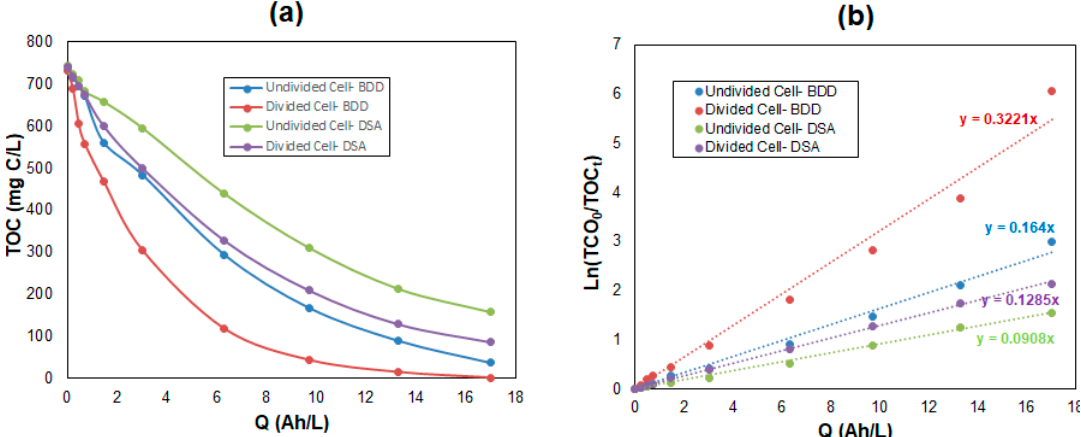
Figure 3. ( a ) Changes of TOC, and ( b ) First-order prediction with the specific electric charge during electrolytic treatment of synthetic urine at pH 5.5 using BDD and DSA anodes and a stainless steel cathode at 20 mA/cm 2 with a flow rate of 800 mL/min in undivided and divided cells.